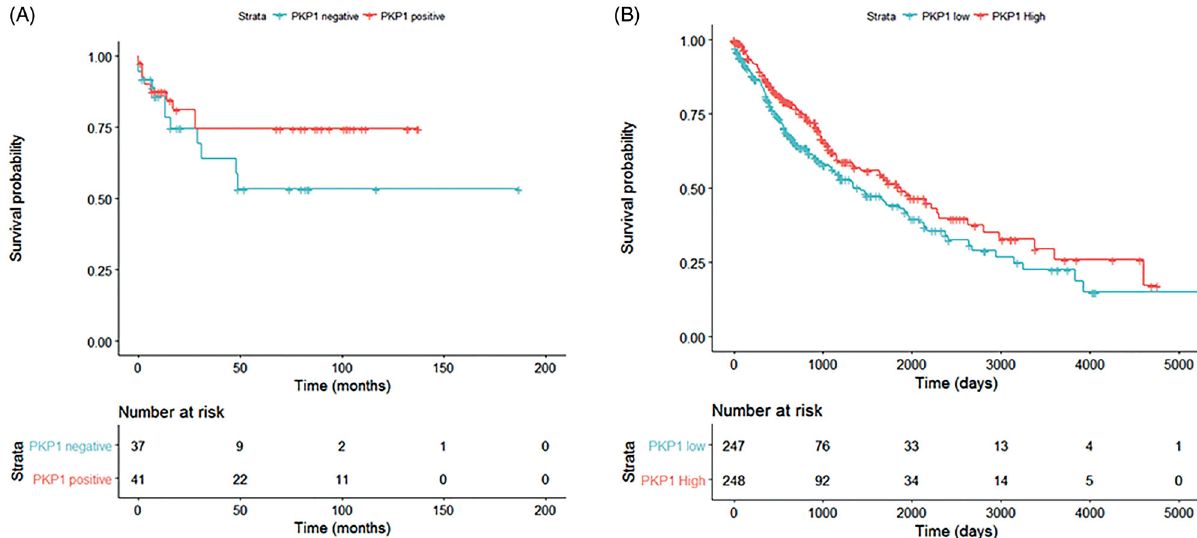
Figure 5. Survival analyses for PKP1 expression in lung cancer patients. (A) Survival analysis of our cohort of 38 SCC and 40 AC patients, classified as ‘ PKP1-nega- tive ’ or ‘ PKP1-positive ’ according to the immunohistochemical staining of PKP1. (B) Survival analysis of the TCGA-LUSC cohort ( n ¼ 495 SCC patients), classified according to their RNA-Seq-measured PKP1 RNA level as ‘ PKP1 low ’ (below median value) or ‘ PKP1 high ’ (above median Table 1, available online). In this cohort, a significant relation- ship was found between higher PKP1 expression and better overall survival (Figure 5(B)), obtaining a hazard ratio of